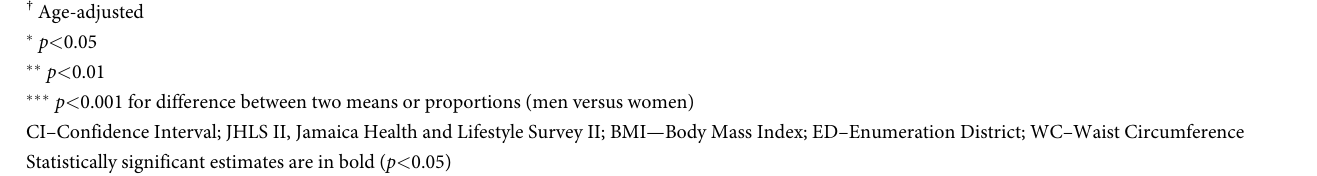
between public parks proximity with mean BMI except in the final model (see Table 4). In the models adjusted for age and sex, a 10% increase in the distance from a public park was associated with a 1.1 kg/m 2 increase in mean BMI ( p = 0.015). When the association between absence of crimes/1000 people/ED per year and mean BMI was examined the association was only statisti- cally significant in unadjusted models in the second tertile–middle class ( p = 0.0496). Mean WC Effect modification by urbanicity was also observed in the association between the number of crimes/km 2 /yr and mean WC ( p = 0.045). Table 5 shows that a one-unit increase in number of crimes/ km 2 /yr. was associated with at least a 0.08 cm increase in mean WC in all models for urban residents.